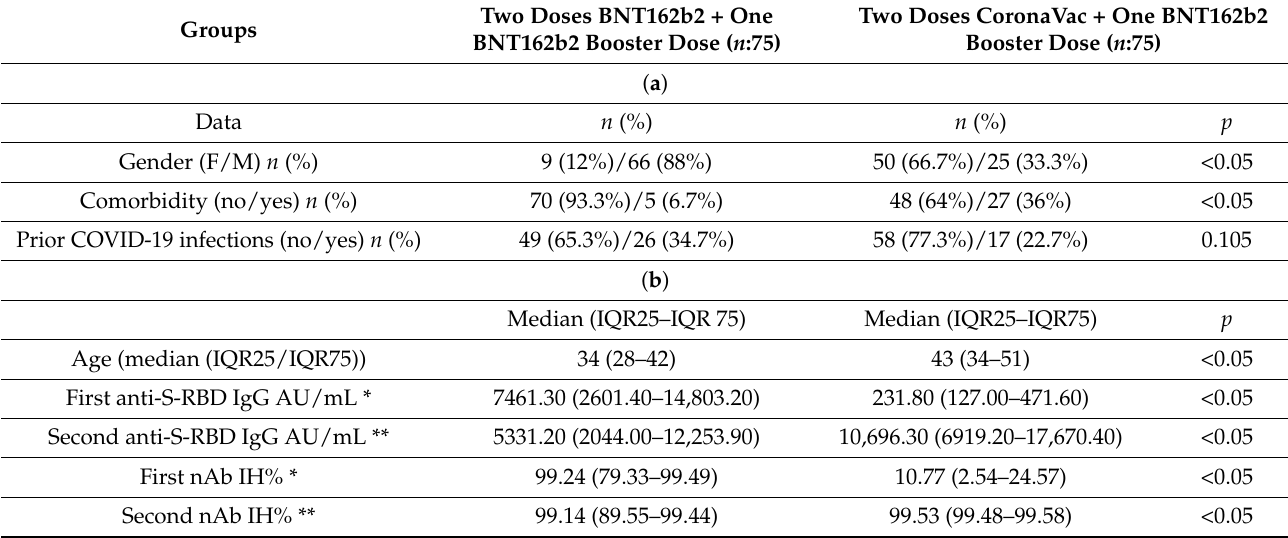
Table 2. (a) Distribution of demographic data of participants who received a booster dose of BNT162b2 after two doses of BNT162b2 or two doses of the CoronaVac vaccine. (b) Distribution of age and antibody results in participants who received a BNT162b2 booster dose after two doses